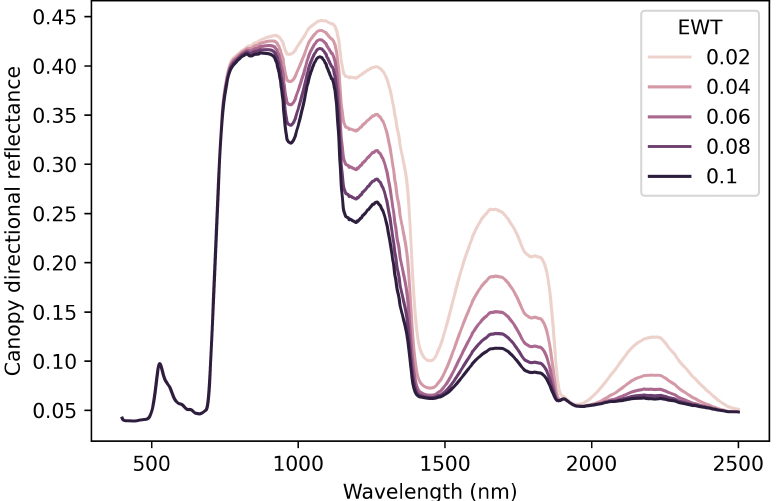
Figure 4. Simulated spectra of plant canopy with different leaf equivalent water thickness (EWT) levels. Generated using the PROSAIL (PROSEPCT-D + 4SAIL) model [46,47], with leaf parameters remaining the same as Figure 3 and canopy and other parameters set as: LAI = 2.0, ALA = 60 ◦ , hspot = 0.5, θ s = 30 ◦ , θ v = 30 ◦ , and φ = 60 ◦